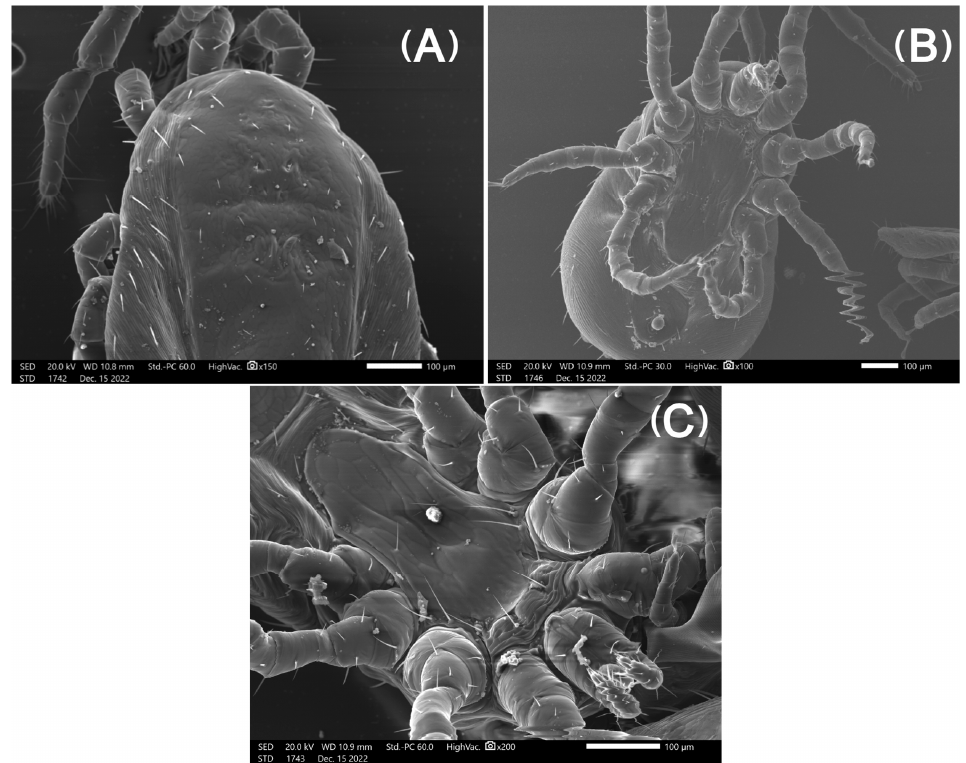
Figure 3. Micrographs of Dermanyssus gallinae after freezing them at ( − 20 °C) for 1 day: dorsal ( A ) and ventral ( B , C ) views. Exoskeletons and limbs are intact with no visual deformities.